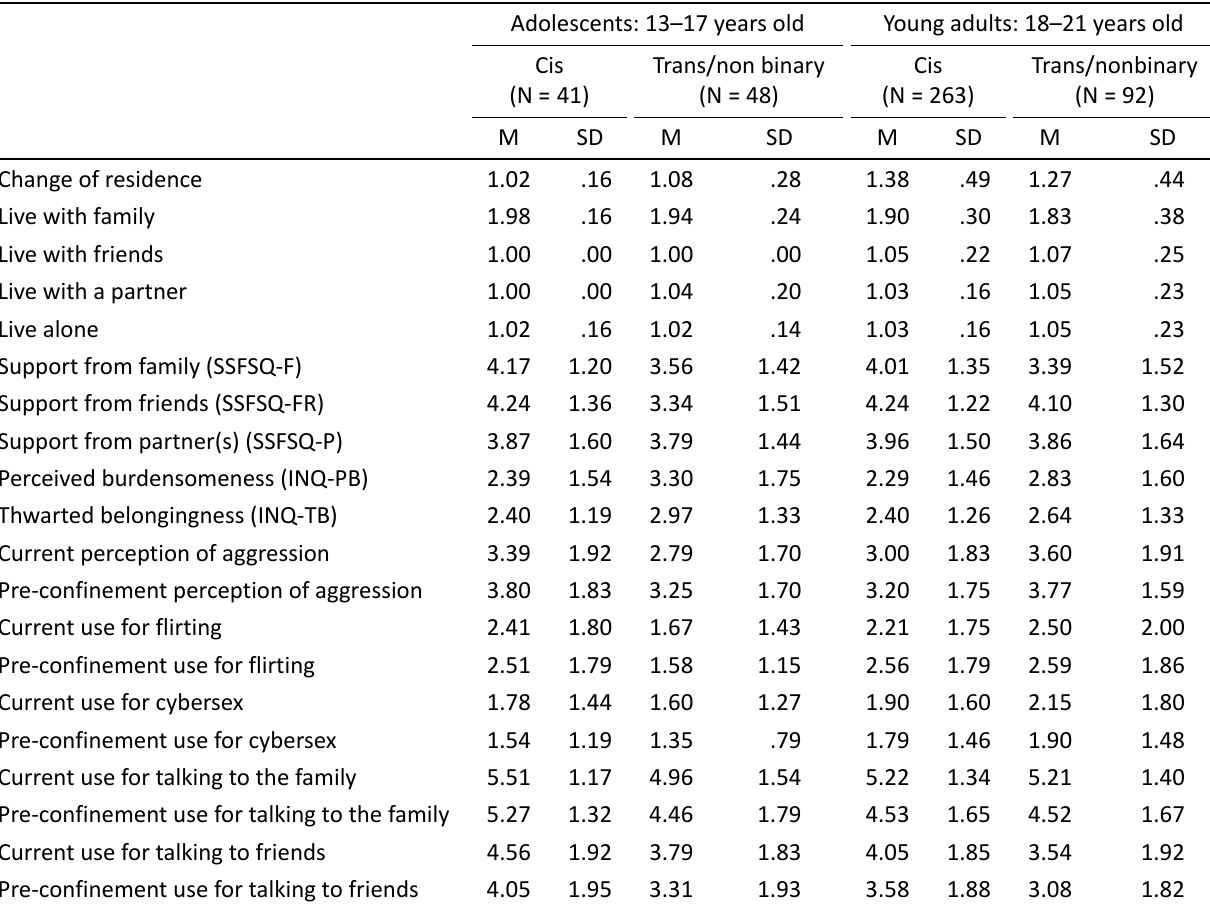
Table 1. Means and standard deviations, divided by age group and gender